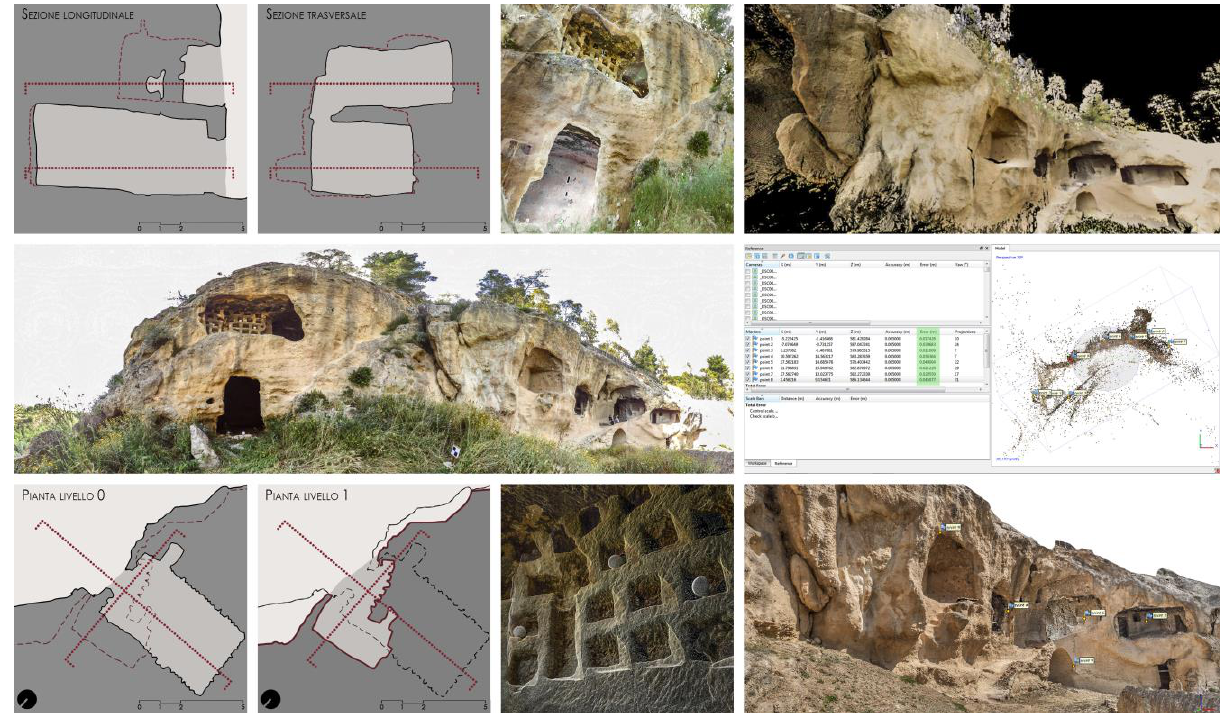
Figure 4. 3D laser scanning and Image-based 3D